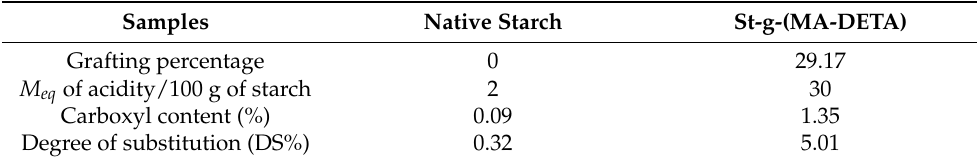
Table 6. Carboxylic acid content of native starch and St-g-(MA-DETA).